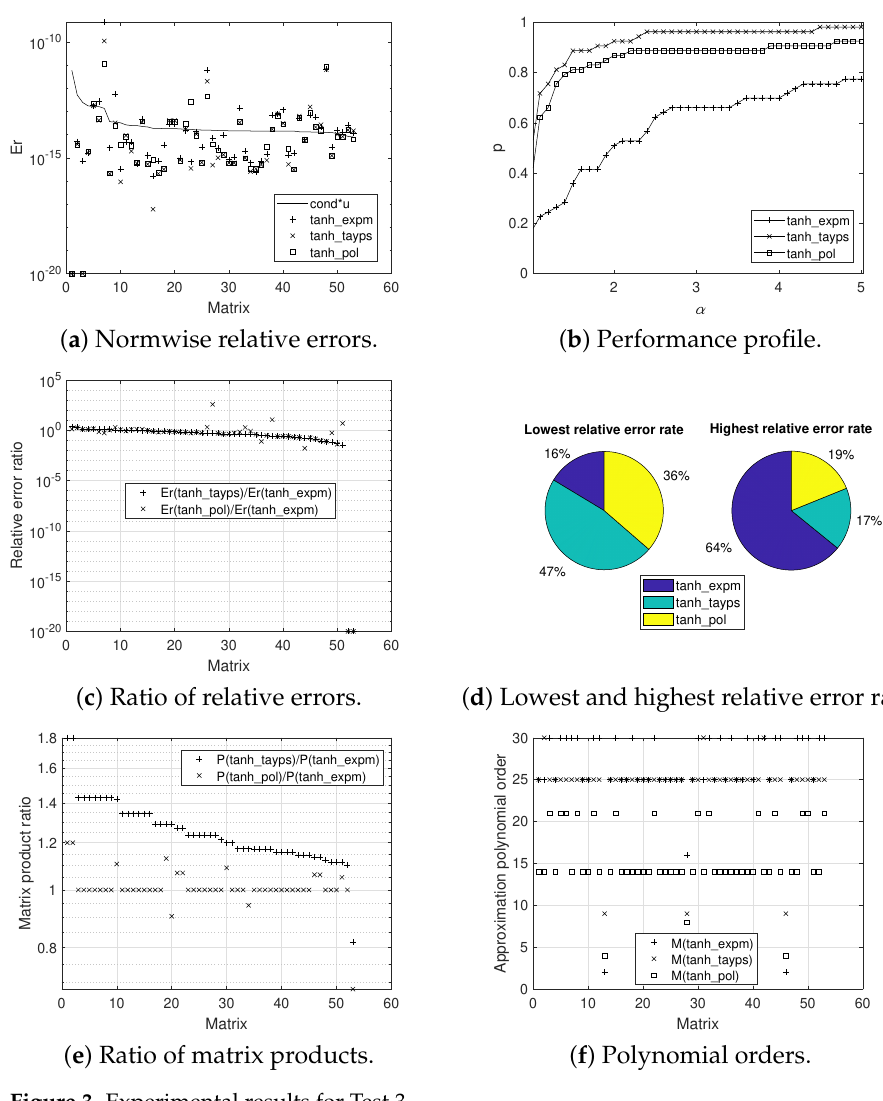
Figure 3. Experimental results for Test 3. Table 5. The minimum, maximum, and average parameters m and s employed for Tests 1–3, respec-